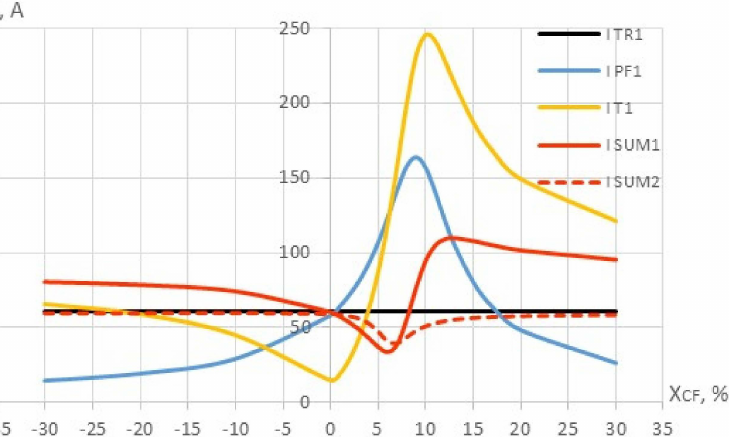
Figure 6. The dependences of the 5th harmonic currents I TR1 , I T1 , I PF1 , I SUM1 , I SUM2 on the passive filter capacitance X CF